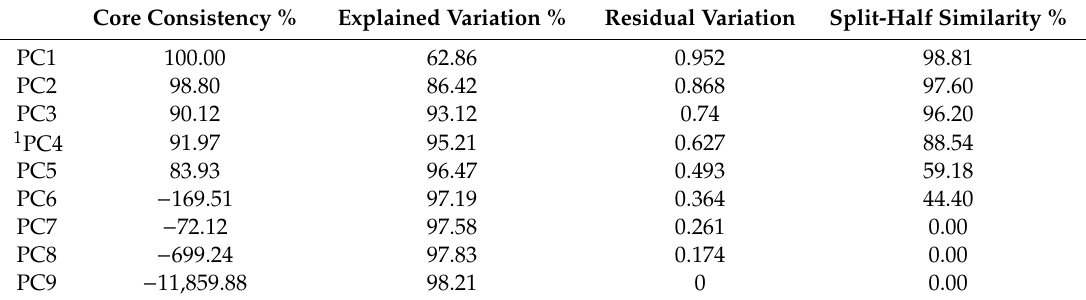
Table 1. Results from non-negative constrained parallel factor analysis (PARAFAC) model. The scaled residual variance, explained variance, core consistency and split similarities are shown for models having between 1 and 9 components. For presentation reasons, the residual variance is scaled to the maximum residual